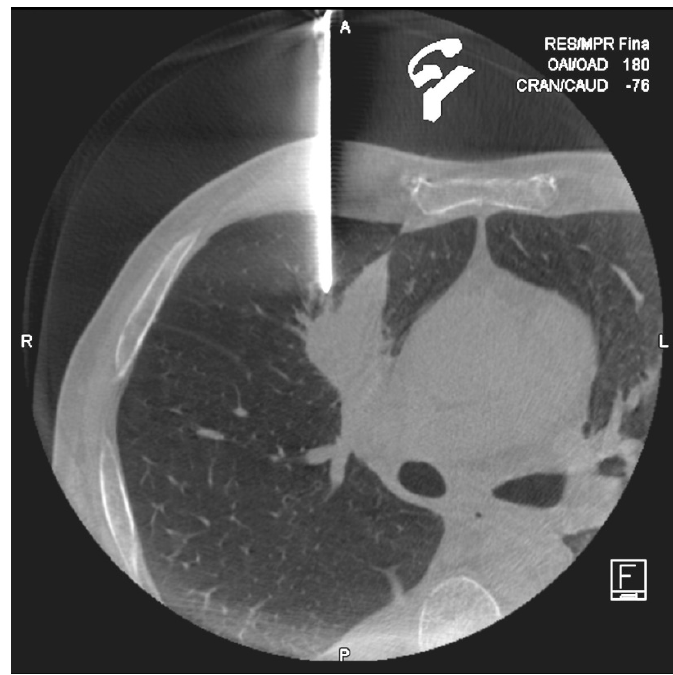
Figure 3. Cone-Beam computed tomography (CT) performed after coaxial introducer placement in a 58year old man. Control CT confirmed the exactly position of the needle tip.